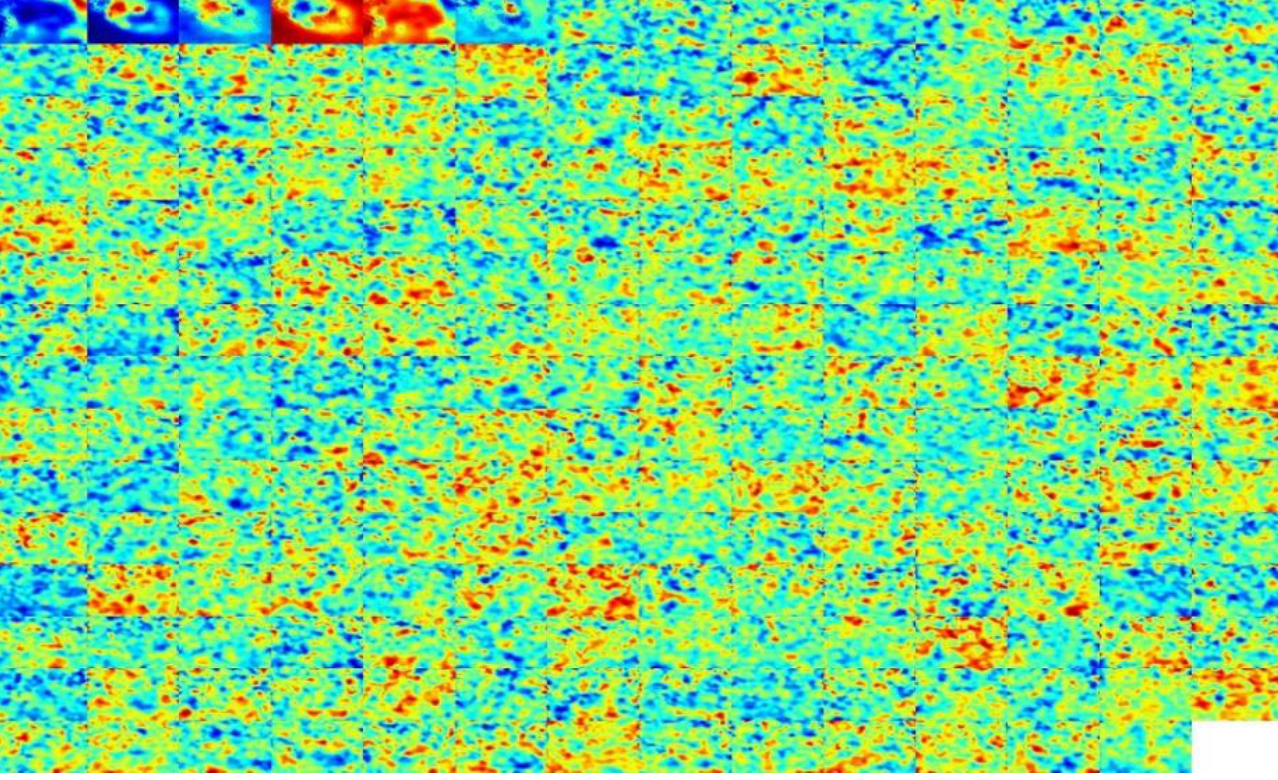
Figure 13. A total of 209 selected features were used for Au prediction. The selected features are sliced at an elevation of 1000 m.